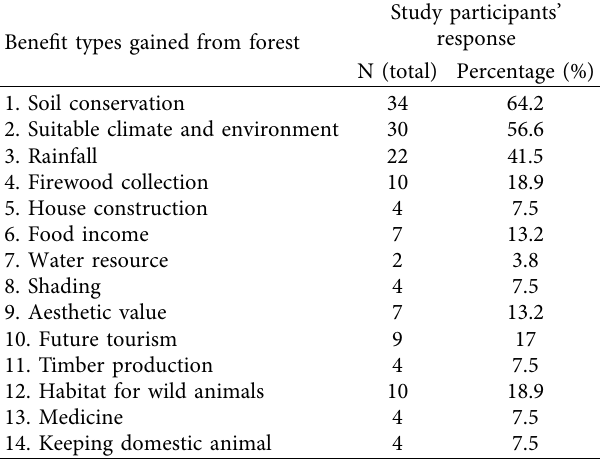
Table 13: Benefits of the forest to study participants.